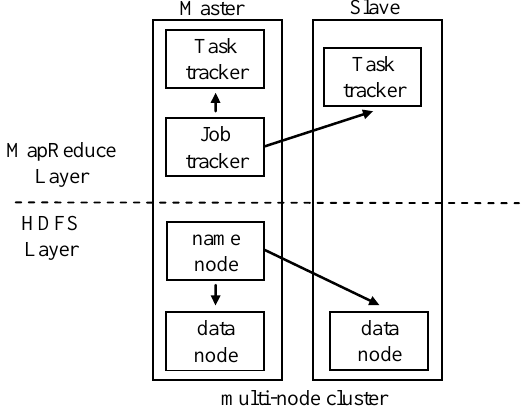
Figure 3. Hadoop Architecture (Bhosale and Gadekar,